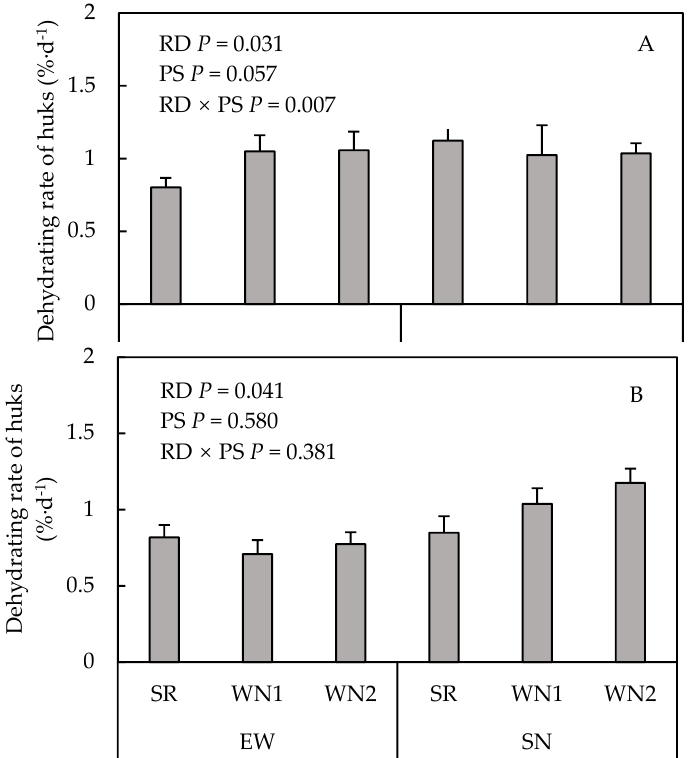
Figure 6. Dehydrating rate of husk leaf during from days after silking (DAS) 12 to DAS 22 ( A ) and during from DAS 22 to DAS 40 ( B ) of maize under two row directions (RD) and three plant spacings (PS) (EW and SN indicate row direction of east to west and south to north, respectively. SR indicates single rows spaced at 65 cm; WN1 indicates 40 cm twin rows spaced at 90 cm between the paired rows of narrow–wide rows; and WN2 indicates 40 cm twin rows, spaced at 160 cm between the paired rows of narrow–wide rows.). Bars denote the SE of the mean ( n = 3).